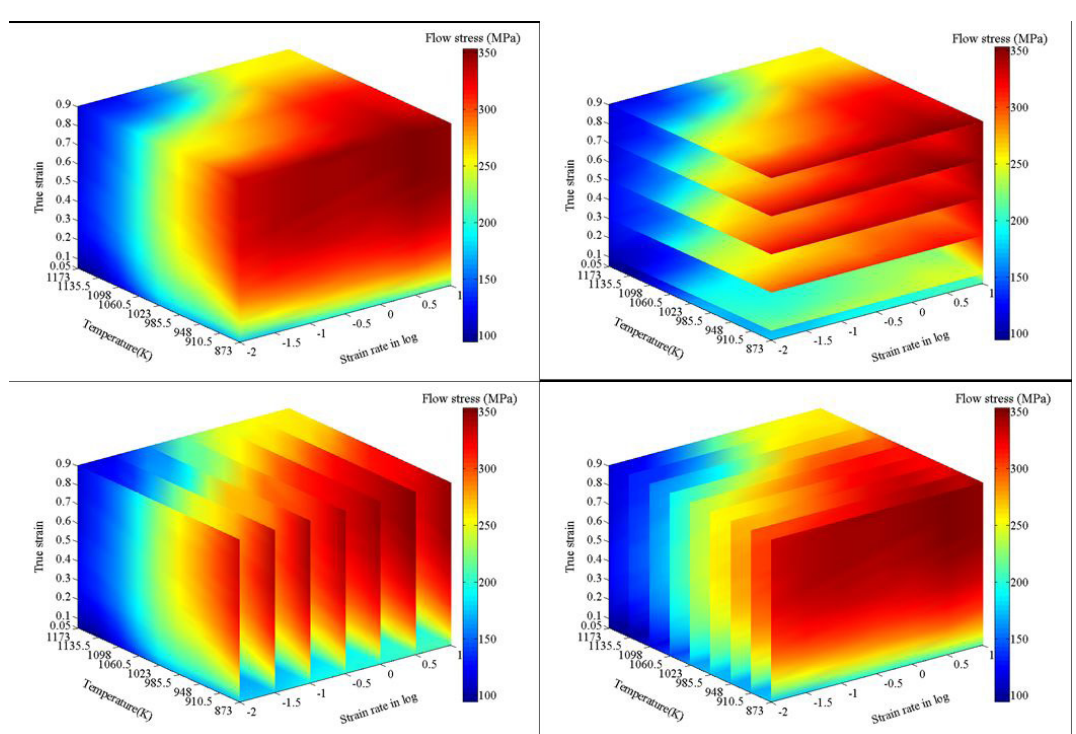
Figure 7. The 3D plot of flow stress within the temperature range of 873–1173 K, logarithm strain rate range from –2 to 1 and strain range from 0.05 to